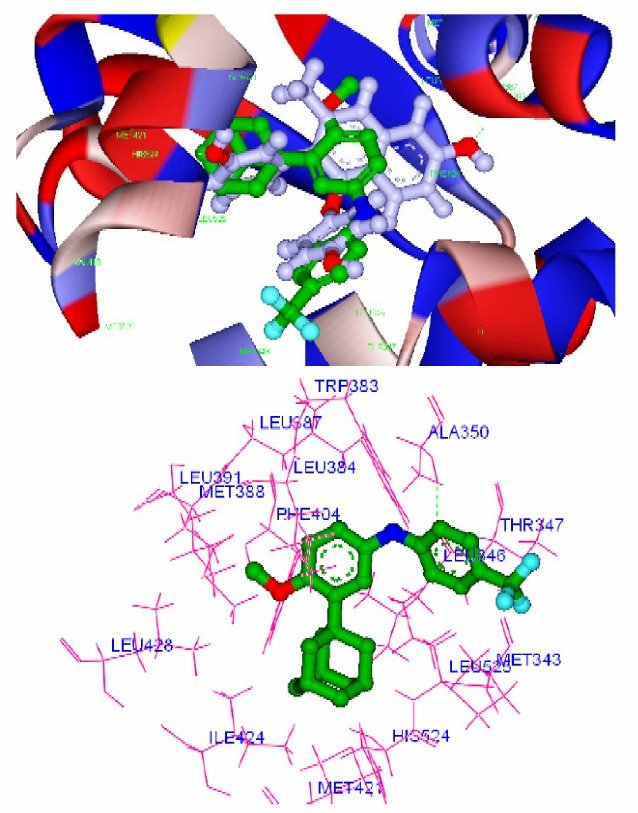
Figure 5. Molecular docking analysis showing the most active compound 4c and its comparison with GW368 (upper panel); the interaction map of compound 4c at the ligand-binding domain (LBD) region of ER(lower panel) also shown using Accelrys DS visualization